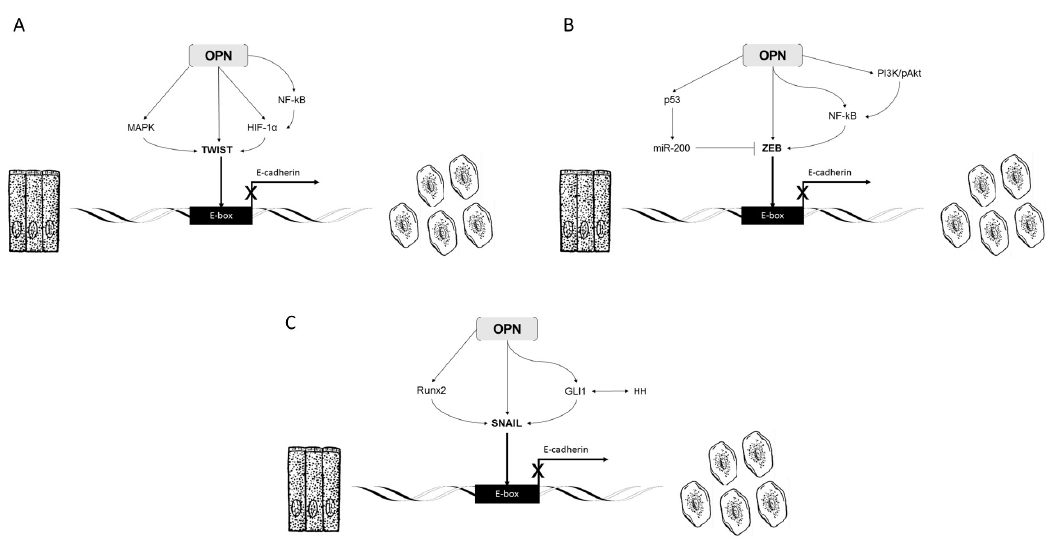
Figure 2. Overview of key EMT pathways regulated by osteopontin directly and indirectly. ( A ) Regulation of TWIST and EMT by OPN; ( B ) Regulation of zinc finger E ‐ box ‐ binding homeobox (ZEB) and EMT by OPN; ( C ) Regulation of SNAIL and EMT by